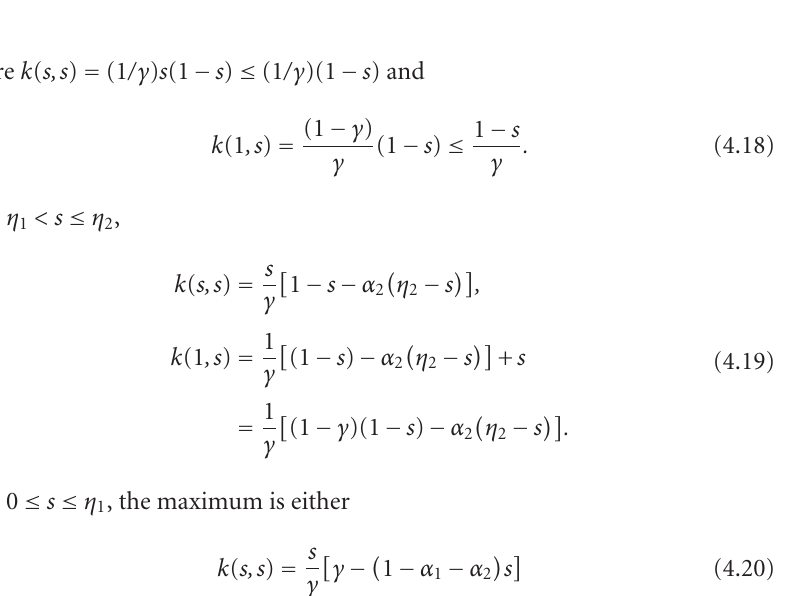
Figure 4.1. Region for positive